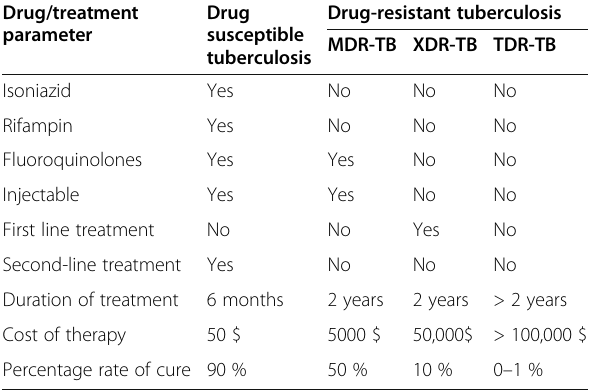
Table 3 Comparative drug treatment schedule for data of TB/ MDR/XDR-TB — cost, duration and success rate Drug/treatment parameter